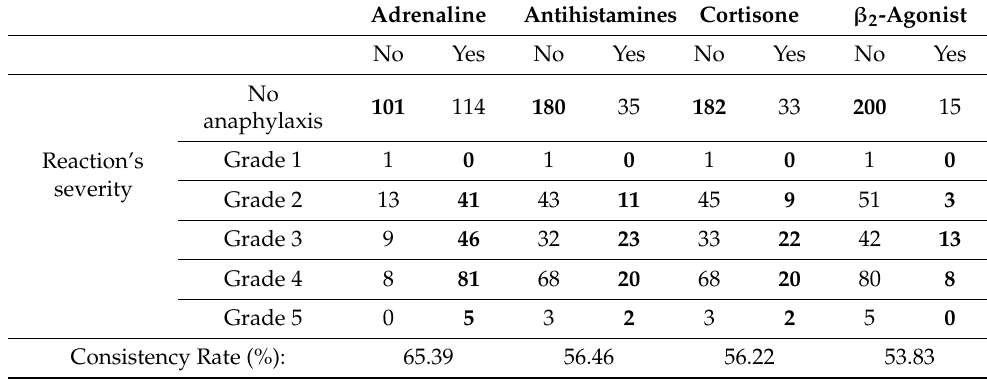
Table 4. Rates of medication provided for future anaphylactic reactions, based on the reaction’s severity. Antihistamines